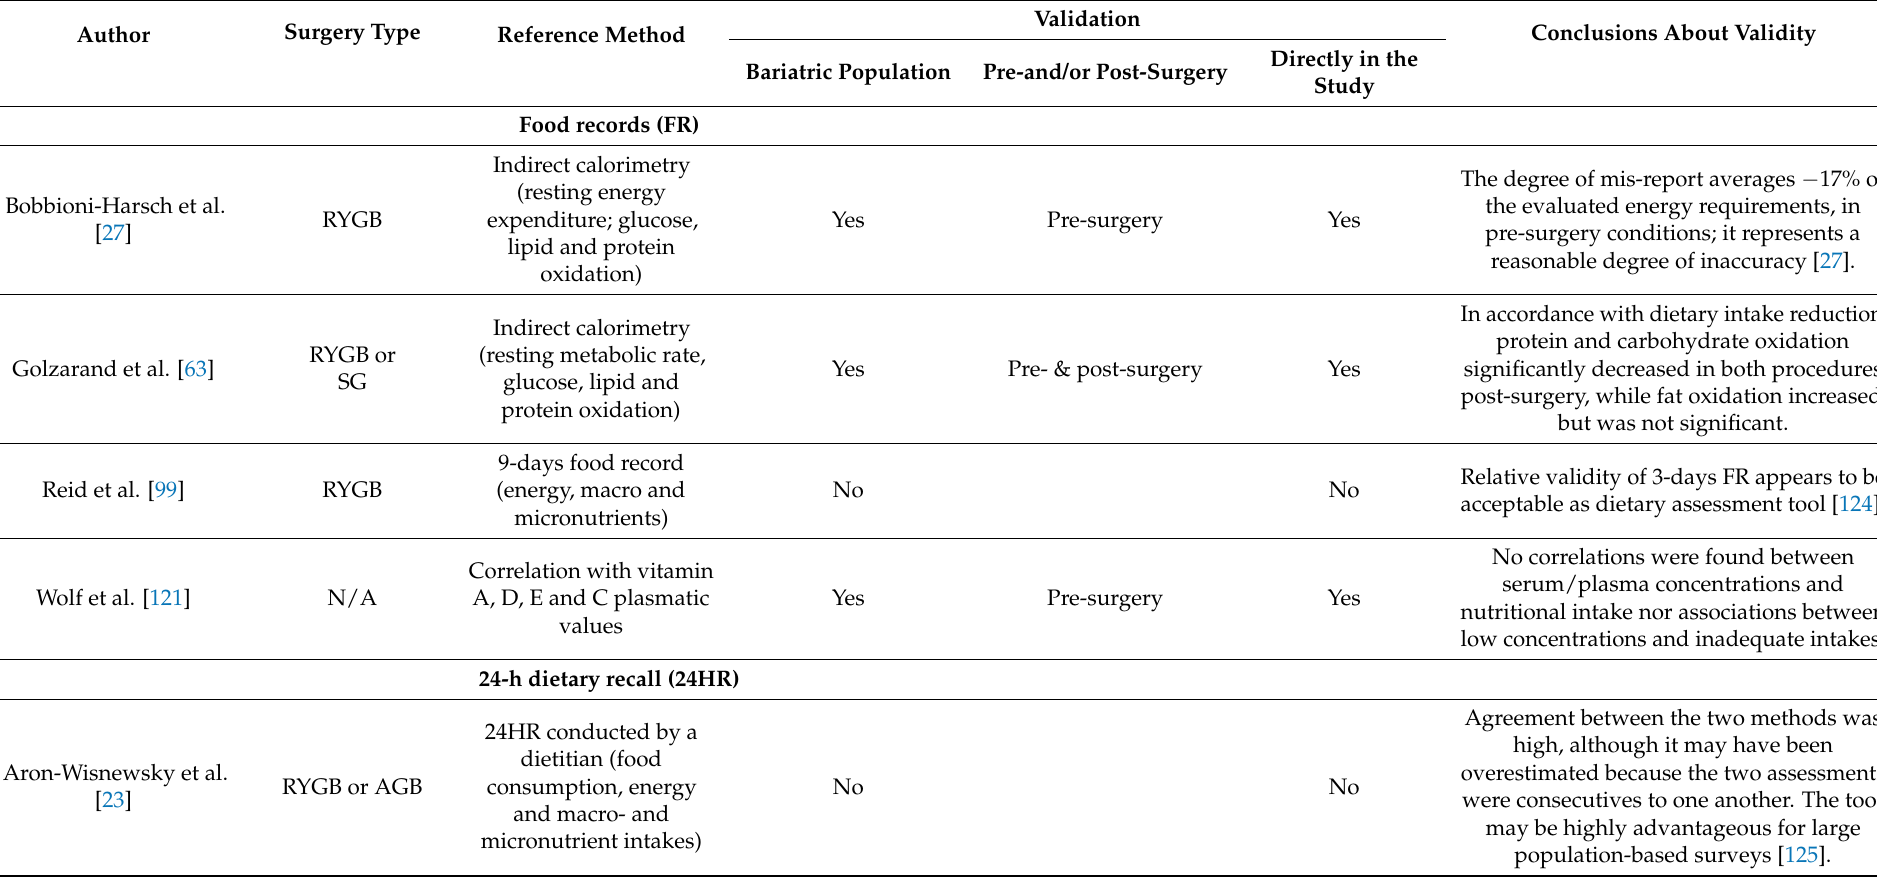
Table 3. Validation of dietary assessment